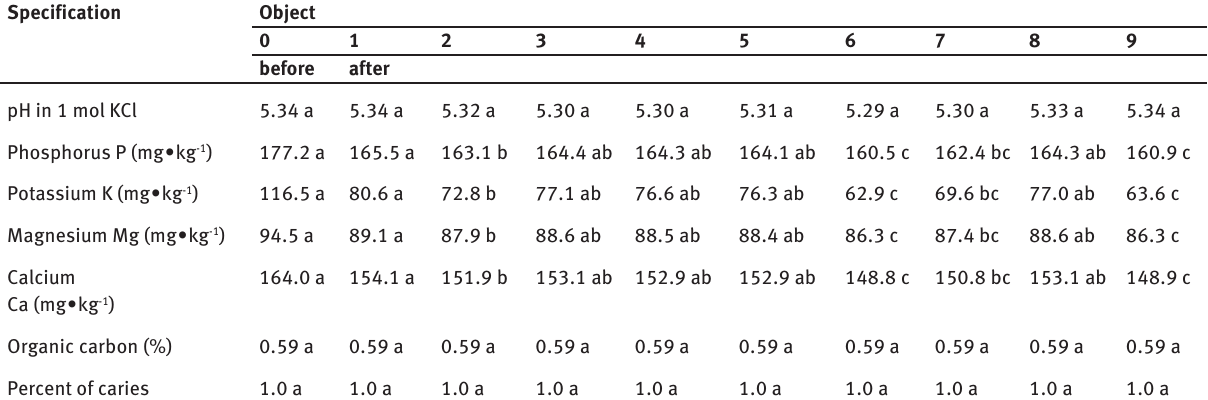
Table 4: Soil reaction and content of nutrients before and after experiments. Specification